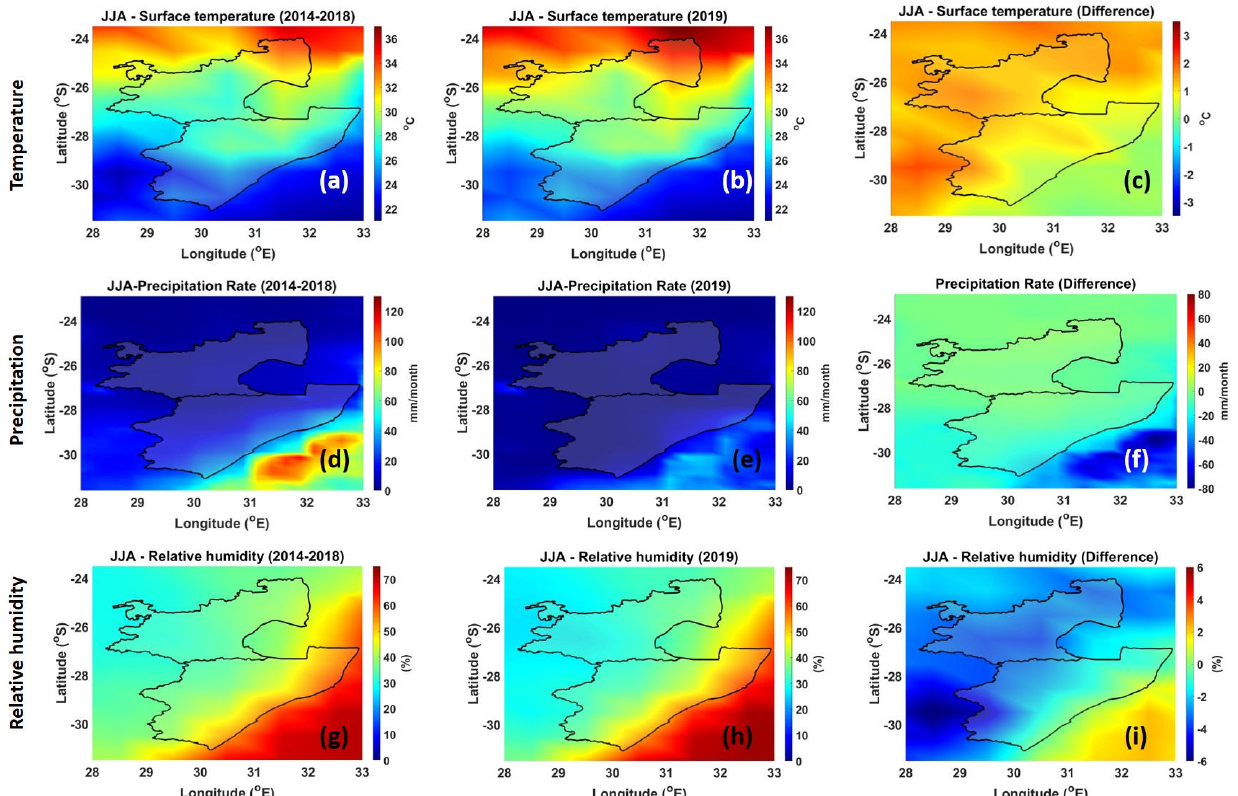
Figure 6. Spatial distribution of temperature ( a – c ), precipitation ( d – f ), and relative humidity ( g – i ) during the JJA